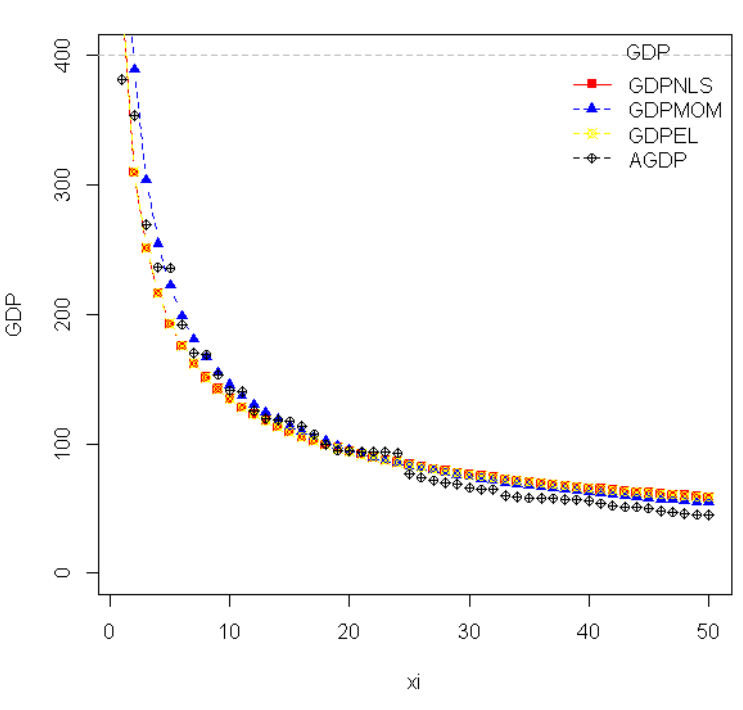
Figure 2. Fitting result figure of the top 50 data of GDP of China in